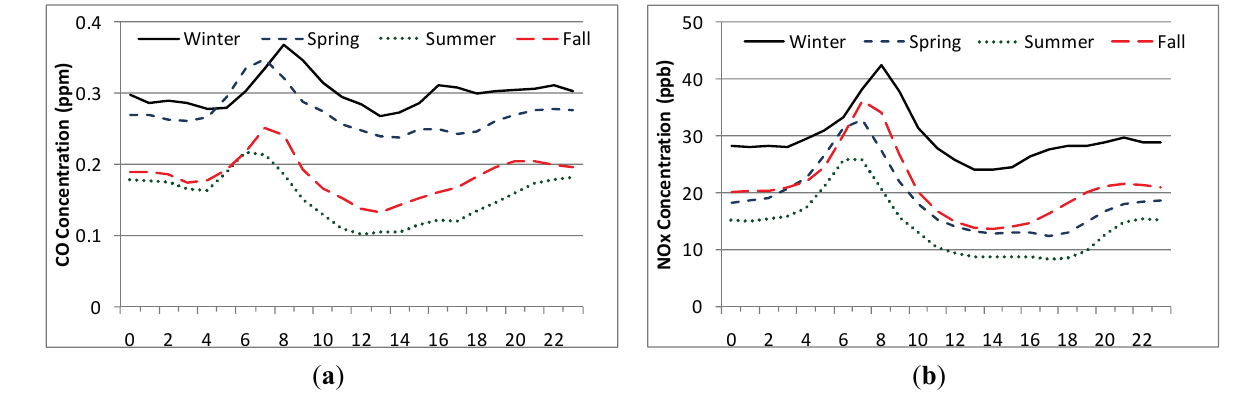
Figure 6. Seasonally averaged hour-of-day trends of meteorological conditions and air quality. ( a ) CO; ( b ) NO ( h ) Relative